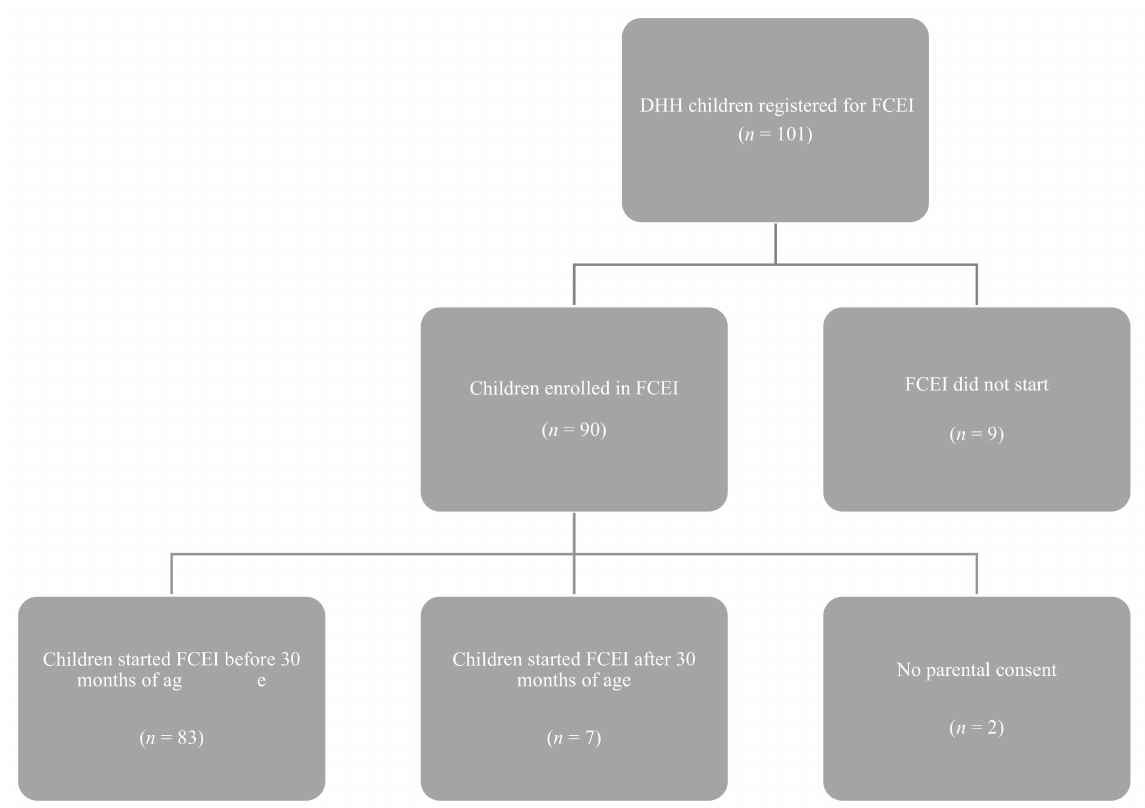
Figure 1. An overview of the inclusion of the participants in this